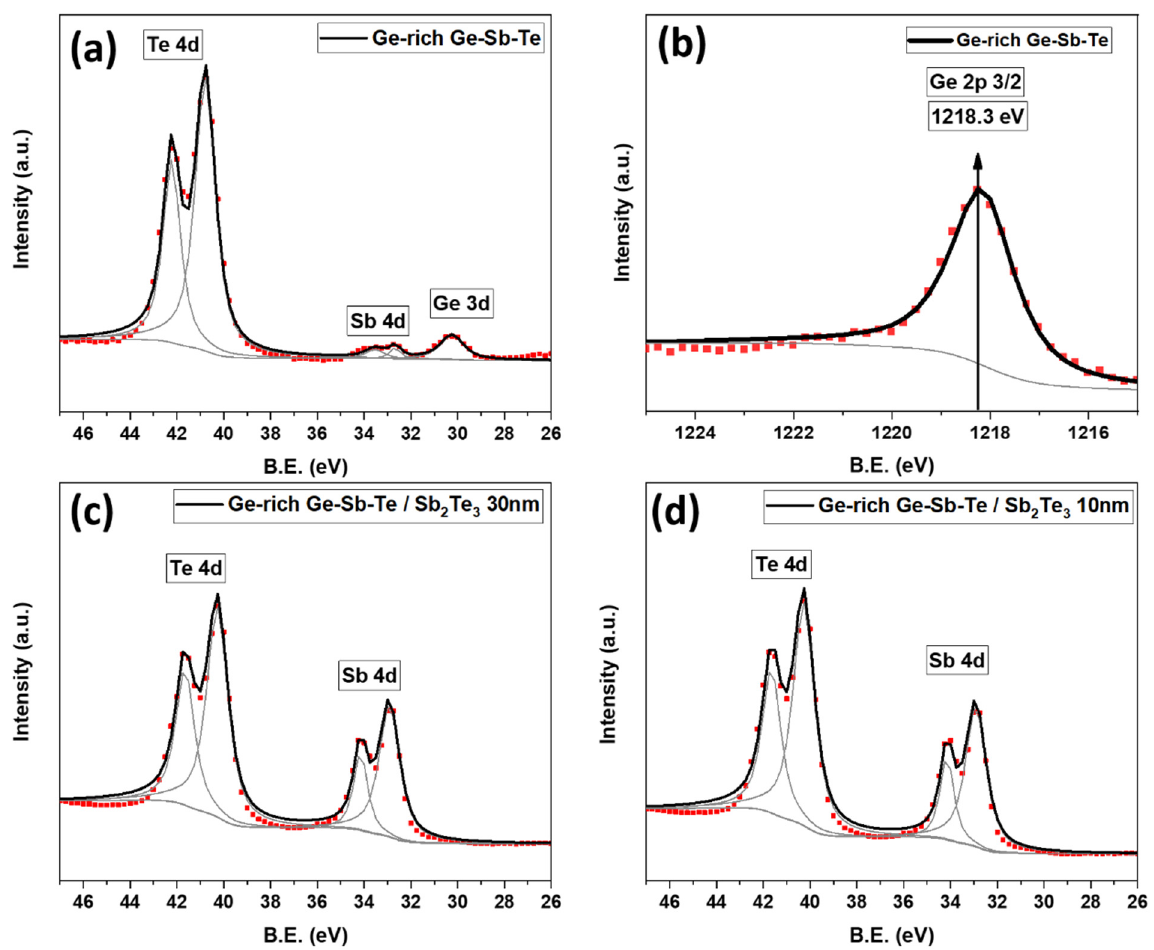
Figure 3. XPS spectra for ( a ) Te_4d, Sb_4d; and ( b ) Ge_2p region for GGST core NWs; ( c ) Te_4d, Sb_4d region for GGST/ST core-shell NWs with 30 nm shell thickness; ( d ) Te_4d, Sb_4d region for GGST/ST core-shell NWs with 10nm shell thickness; (dots–experimental data; solid lines—fit). Next, we analyzed the GGST/ST core-shell NWs with different shell diameters.